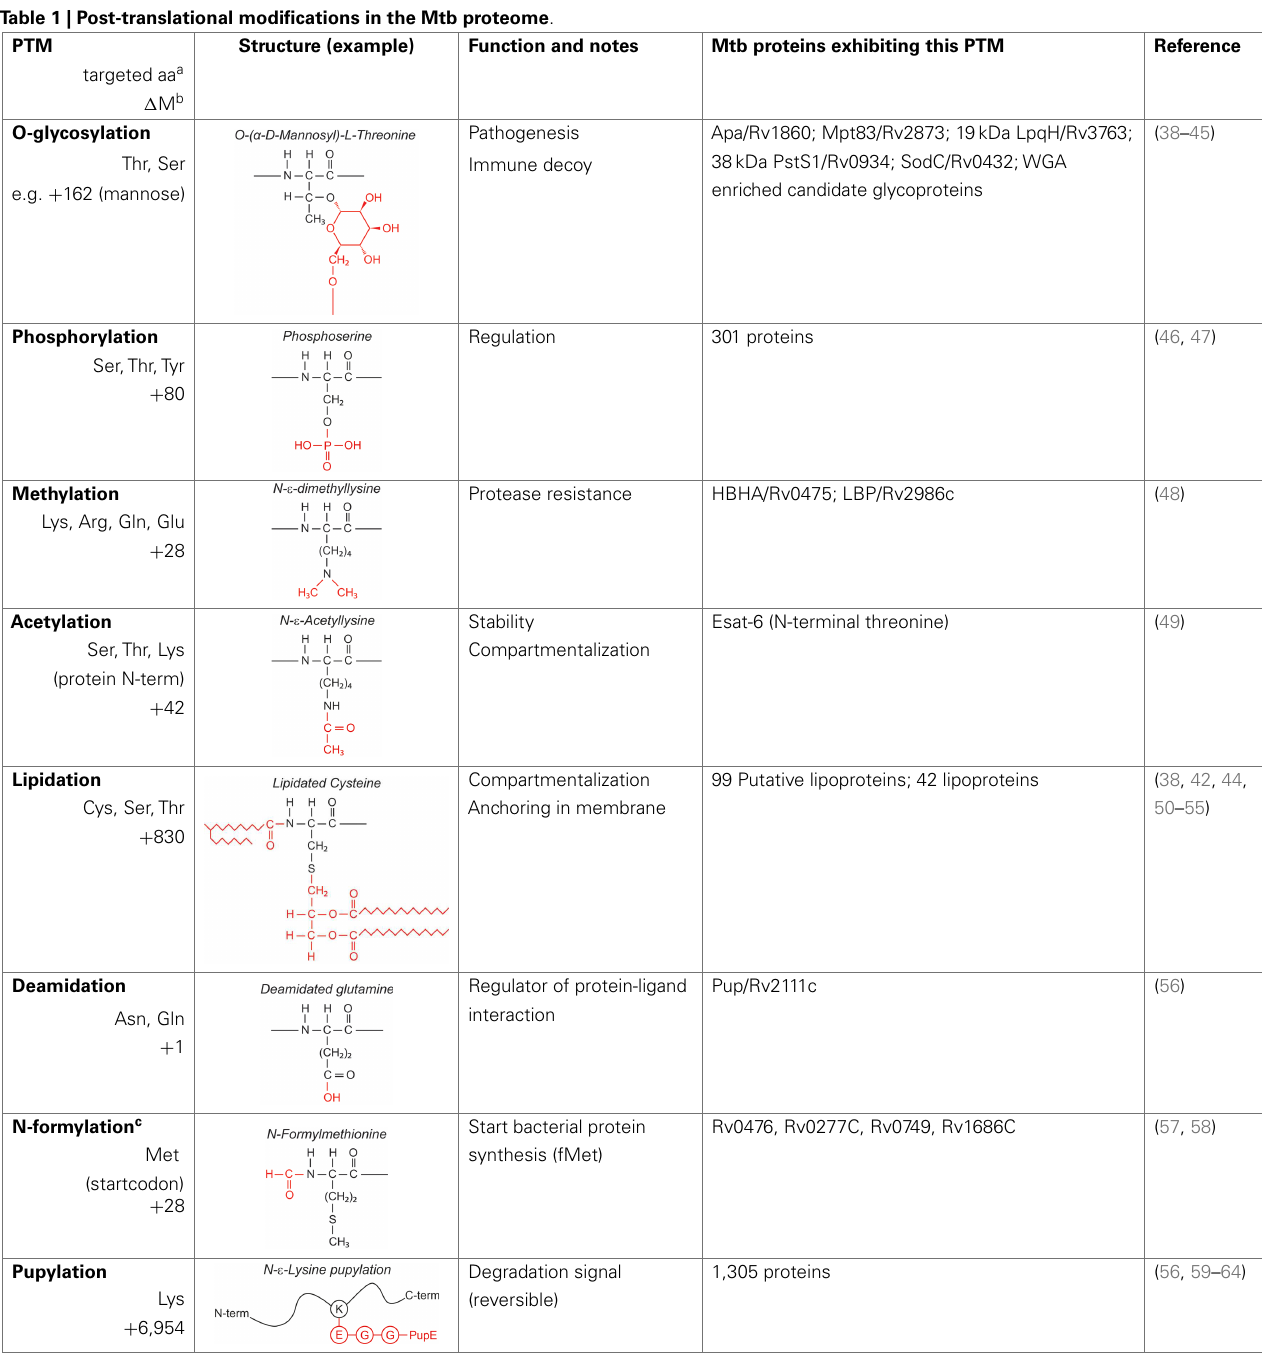
Table 1 | Post-translational modifications in the Mtb proteome